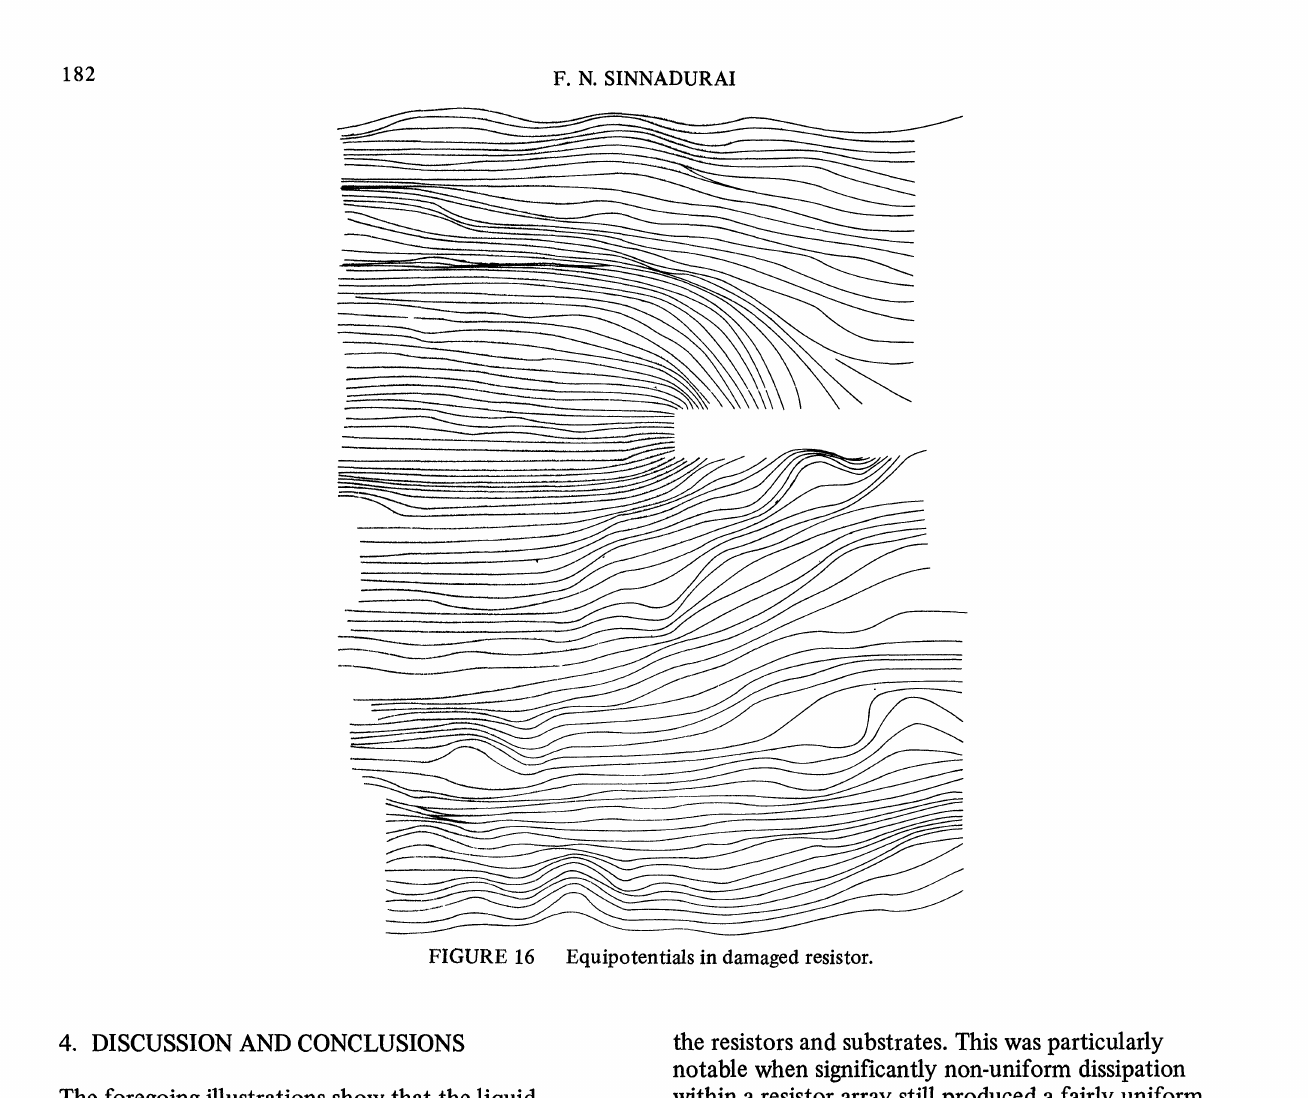
FIGURE 16 Equipotentials in damaged